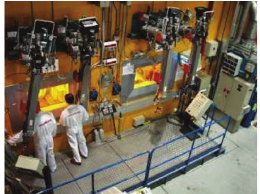
Fig. 8. Preparing an inventory.